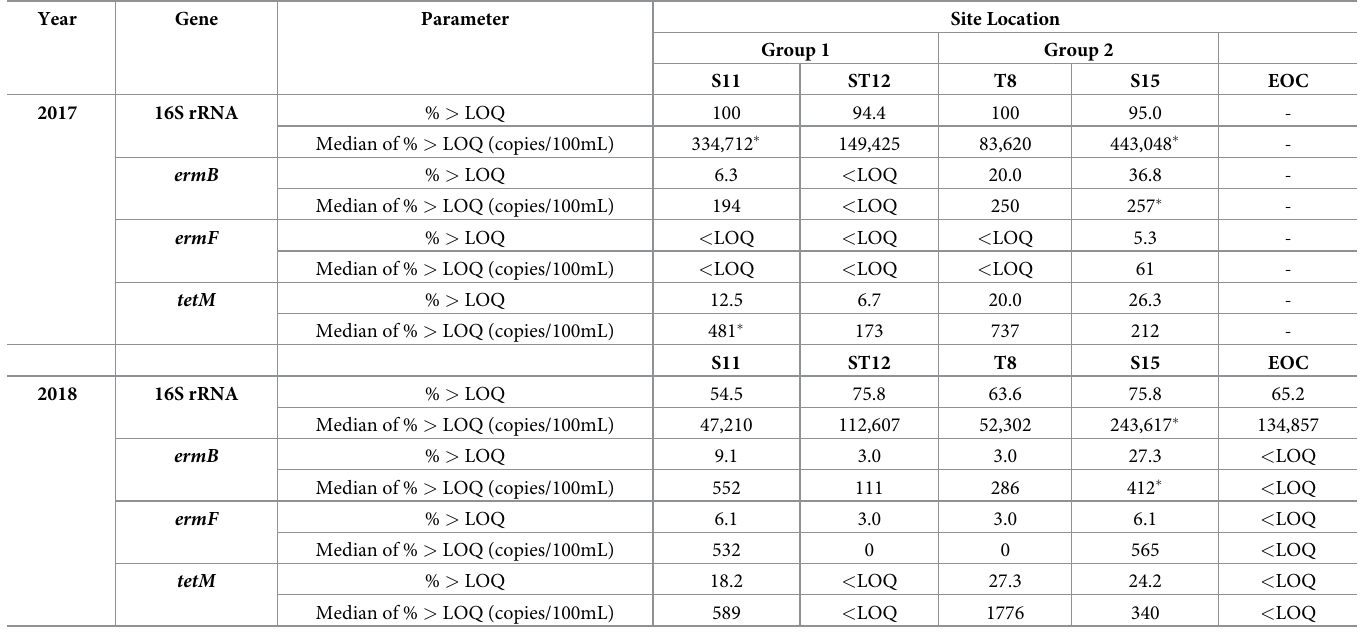
Table 3. Detection frequency and median copies/100mL above LOQ.